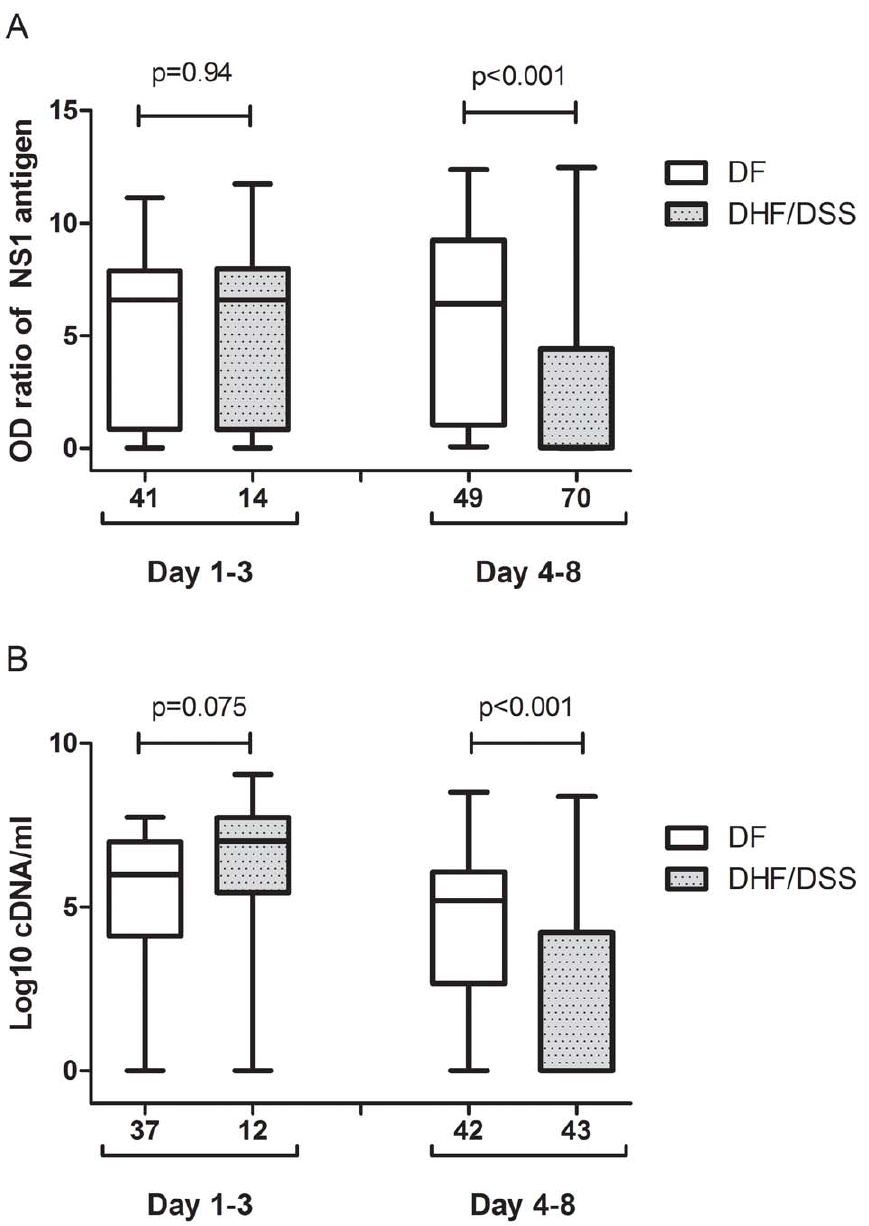
Figure 3. Level of NS1 antigen and viremia by disease severity. Shown are the median, interquartile and 95 percent range of OD ratio of NS1 antigen (A) and log10 cDNA equivalents/mL (B) distributed by disease severity (DF, DHF/DSS). The number of patients is shown under the X axis bar. NS1 antigen OD ratio was significantly higher in DF group than in DHF/DSS group ( p , 0.001) at DOF 4–8 (A). Log10 cDNA equivalents/ml was significantly higher in DF group than in DHF/DSS group at DOF 4–8 ( p , 0.001)